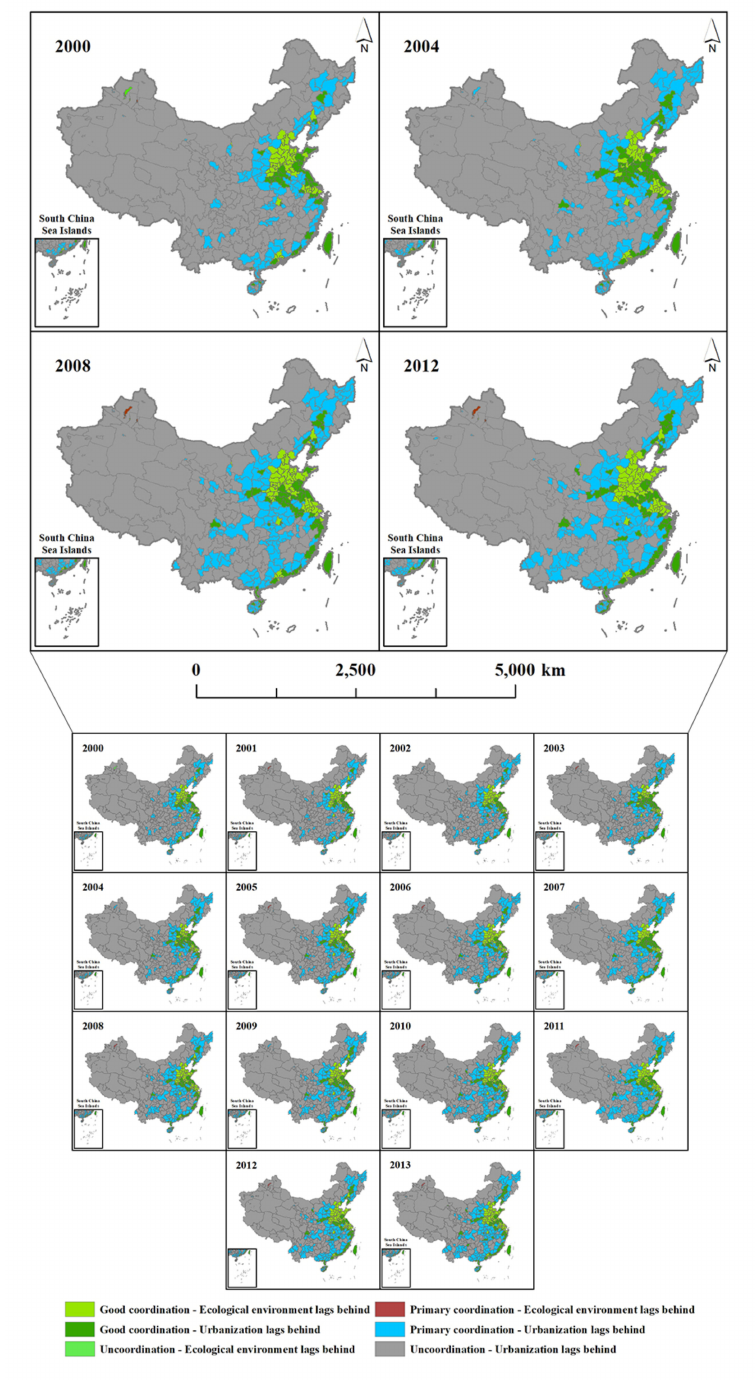
Figure 11. China’s CCD classification map from 2000 to